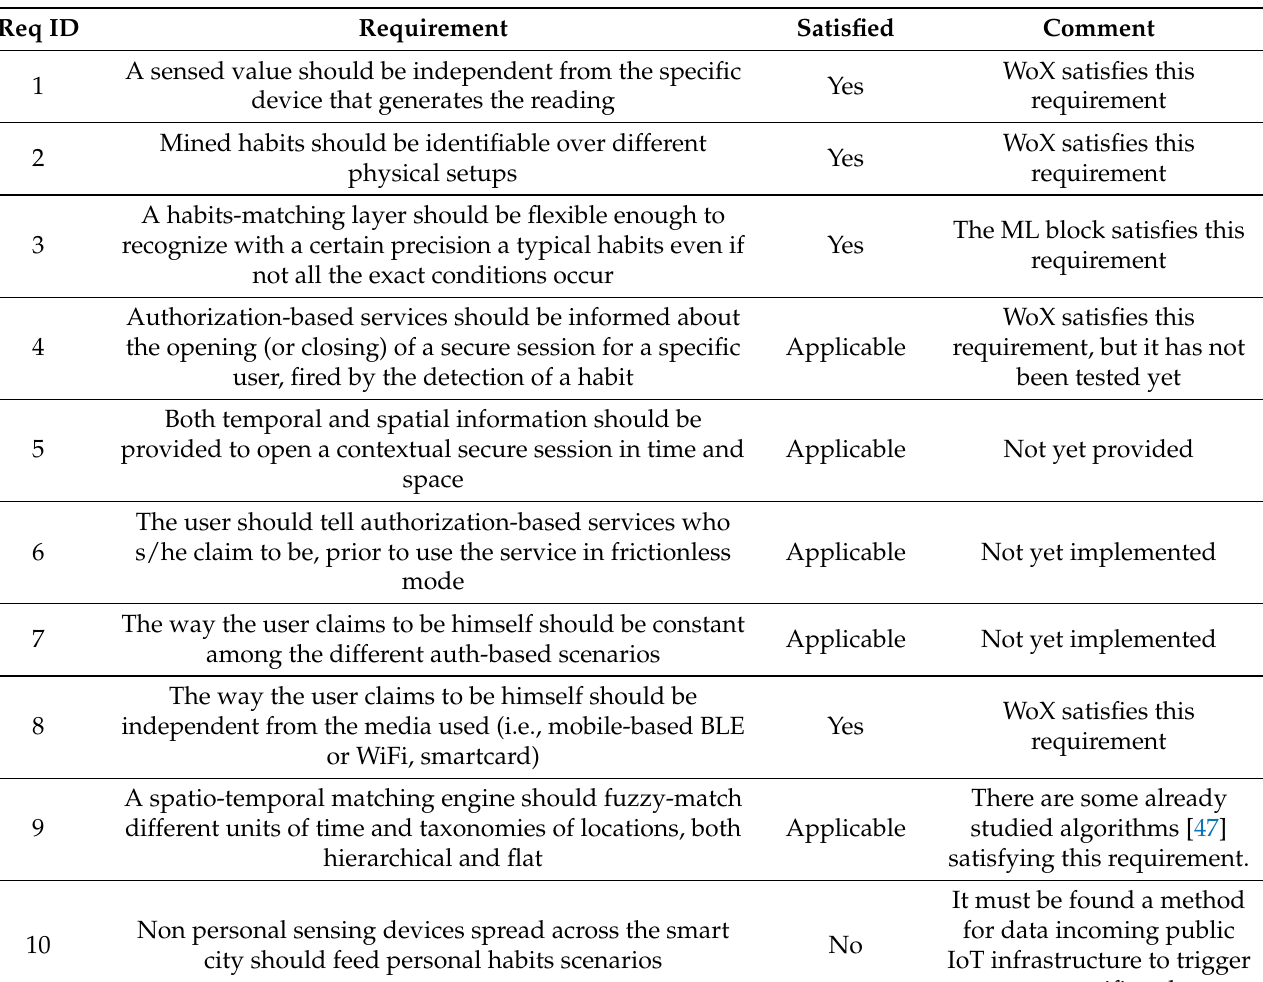
Table 3. Requirements